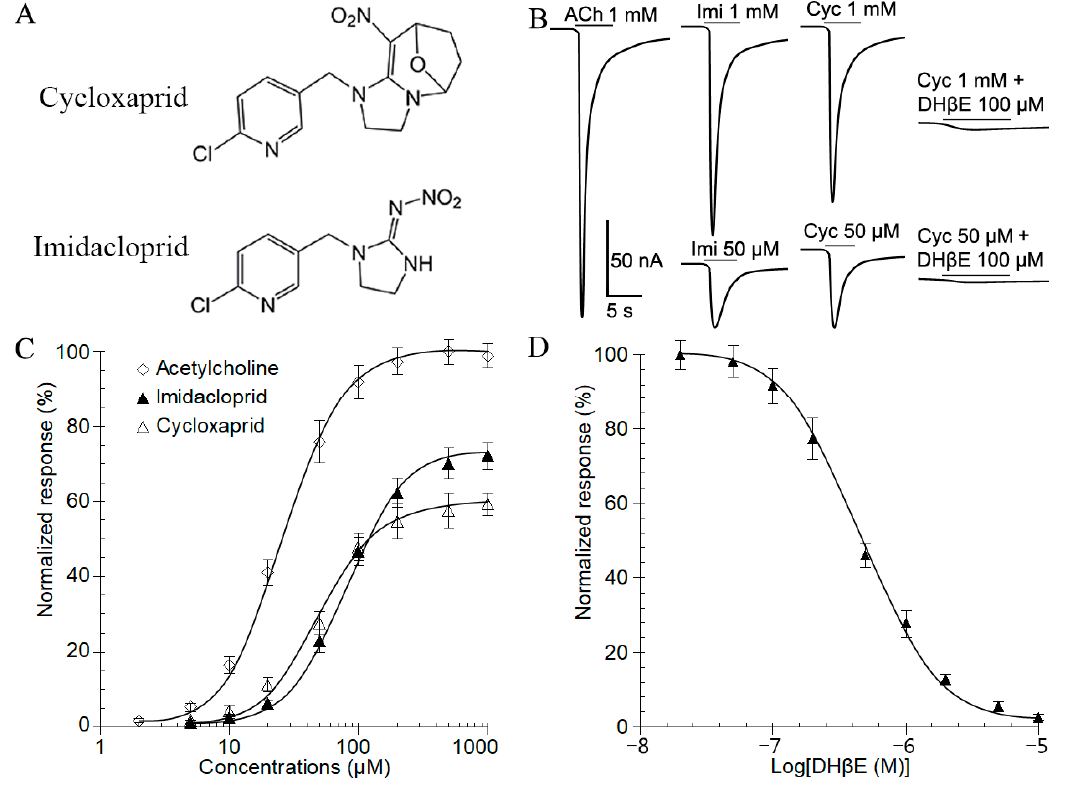
Figure 1. Cycloxaprid acted on recombinant receptor Nl α 1/ β 2 in Xenopus oocytes as a full agonist. ( A ) Chemical structures of cycloxaprid and imidacloprid. ( B ) Representative currents elicited by acetylcholine, imidacloprid, and cycloxaprid on recombinant receptor Nl α 1/ β 2 expressed in Xenopus oocytes. The concentrations (µM) were provided above the currents following drug name, acetylcholine (ACh), imidacloprid (Imi), and cycloxaprid (Cyc). ( C ) Concentration-response curve for inward currents induced by acetylcholine ( n = 7), imidacloprid ( n = 6), and cycloxaprid ( n = 12). The currents were normalized to the maximum currents elicited by 1000 µM acetylcholine and pre- sented as mean ± SEM. ( D ) The dose-inhibition relationship for hybrid receptor Nl α 1/ β 2 ( n = 11). The curve was obtained by perfusing oocytes with increasing concentrations of the antagonist DH β E for 30 s prior to application of 1000 µM cycloxaprid in the continued presence of the antagonist for 10 s. The data were normalized to the response of each oocyte to 1000 µM cycloxaprid and presented as mean ± SEM. Table 1. Agonist potency of acetylcholine, imidacloprid, and cycloxaprid on recombinant receptor Nl α 1/ β 2 expressed in Xenopus oocytes.